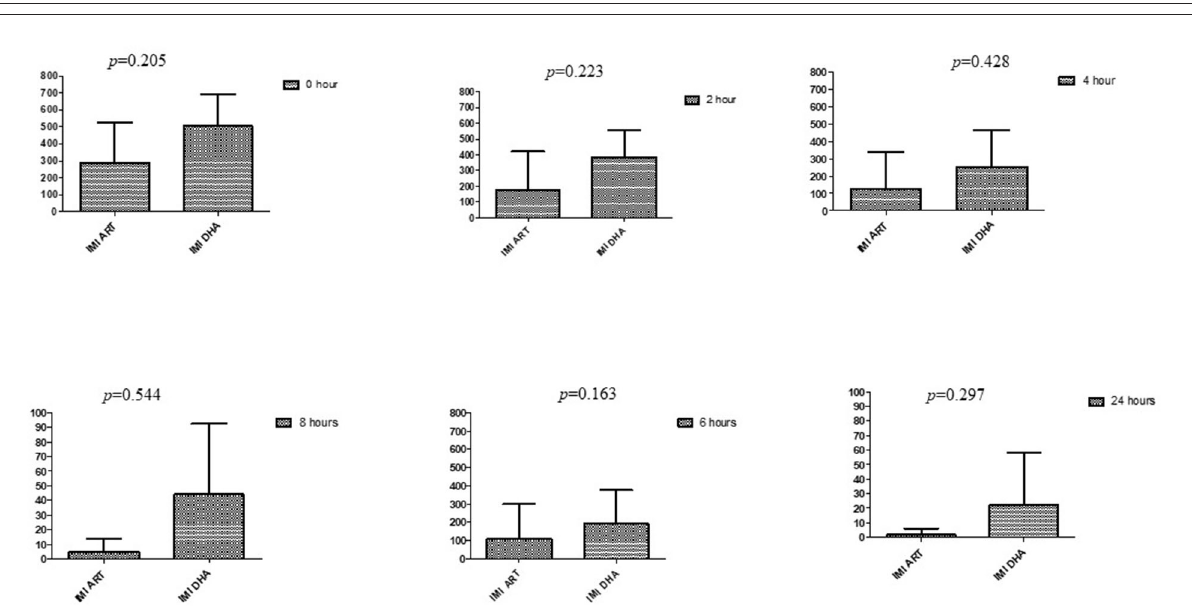
FIGURE2 Comparison of imipenem’s minimum inhibitory concentrations ( µ g/mL) when combined with ART and DHA on E. coli. IMI ART, Imipenem combined with ART; IMI DHA, Imipenem combined with DHA; p < 0.05 indicate a significant difference among MICs of antibiotic combined with ART and